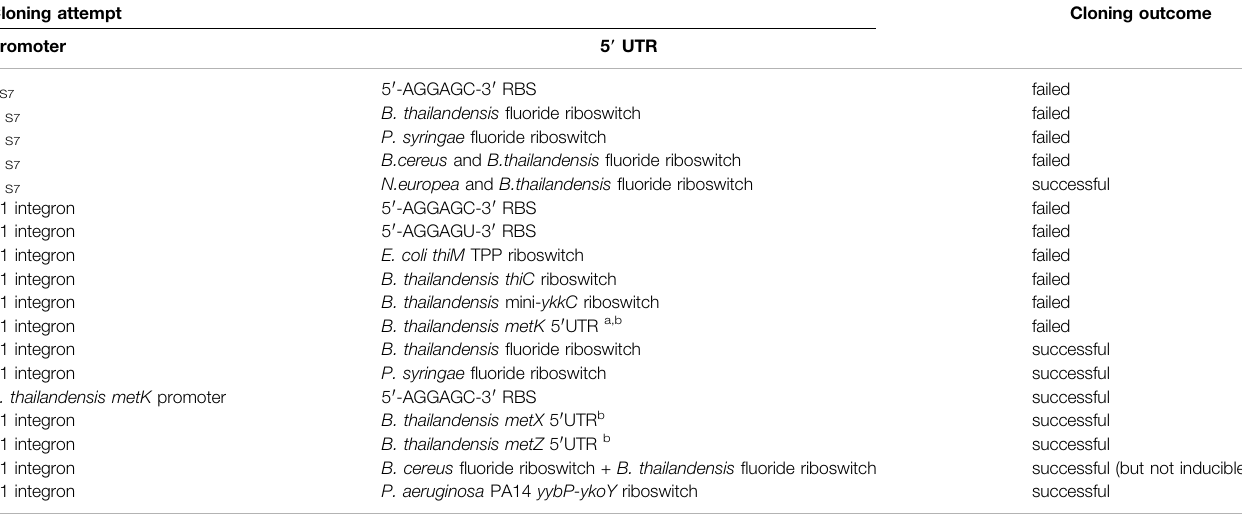
TABLE 1 | Cloning success of the promoters upstream of the lux operon depends on the choice of 5 ′ UTR. Cloning attempt